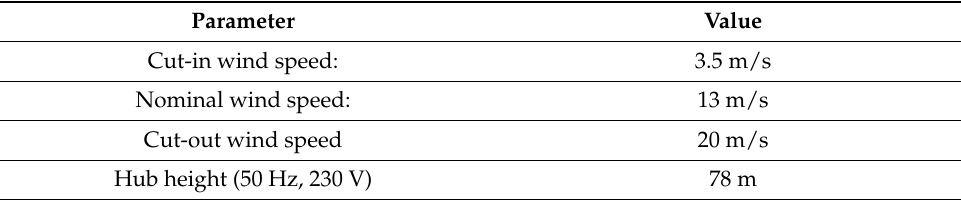
Figure 5. Vestas V82-1.65 turbine power curve. Courtesy of Vestas Wind System. Table 1. Turbine operation parameters. Courtesy of Vestas Wind System.